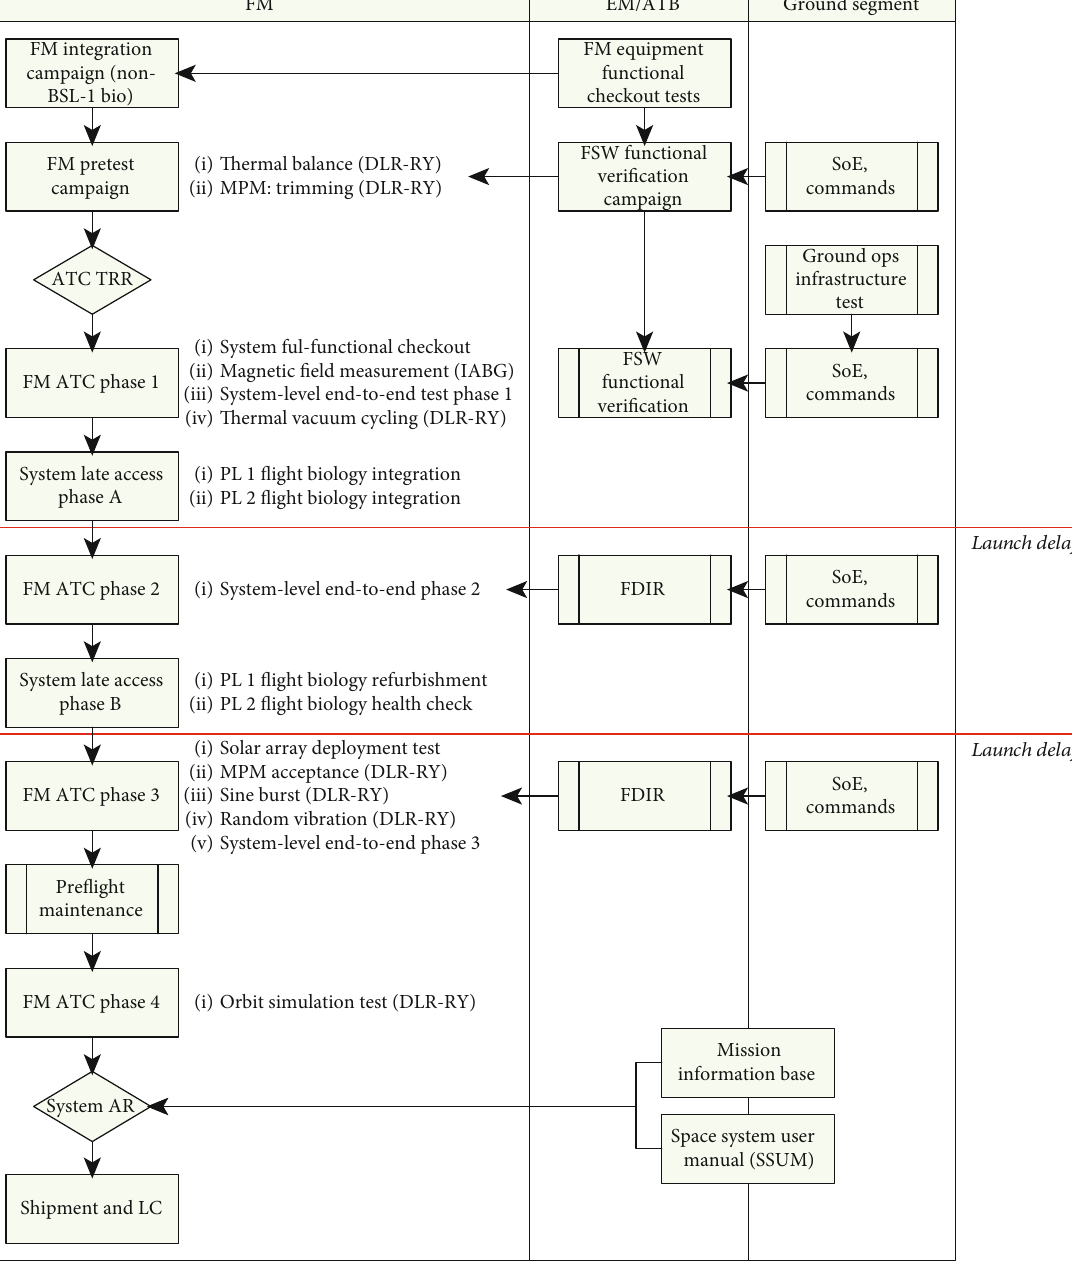
Figure 8: Eu:CROPIS acceptance campaign (tests in order of